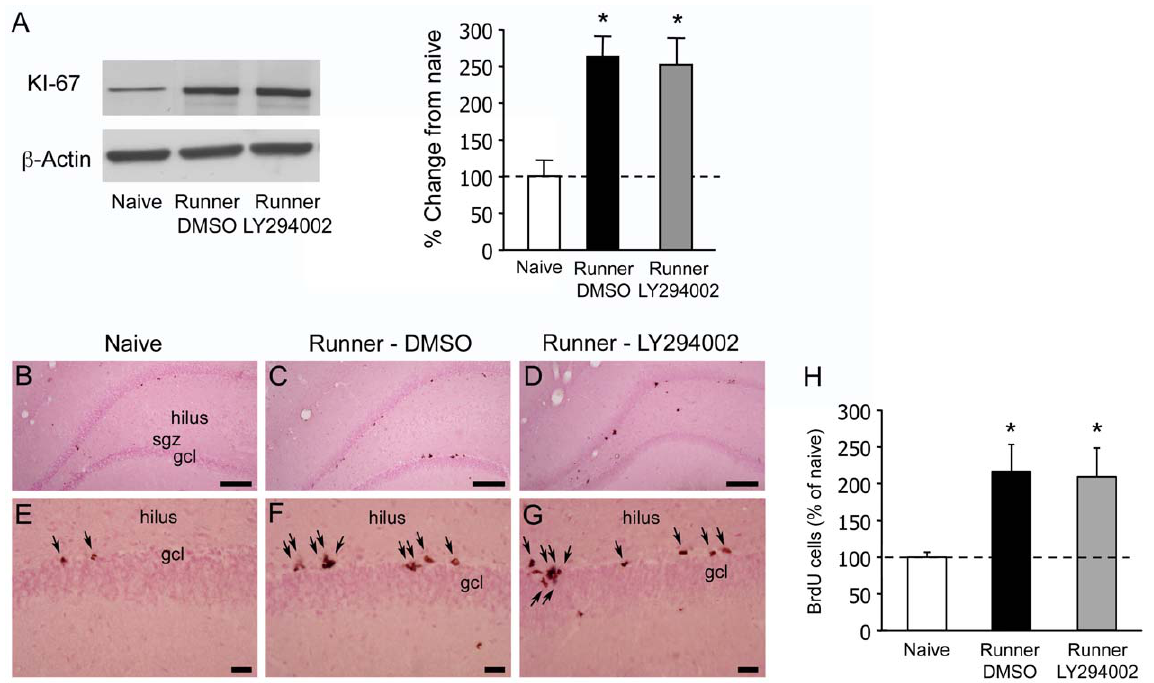
Figure 4. Effect of running and inhibition of the PI3K-Akt signaling pathway on dentate gryus cell proliferation. A. Expression of KI-67 in the dentate gyrus following exercise. KI-67 protein levels are increased in both DMSO-treated runner (Black bars, n=4) and LY294002-treated runners (Grey bars, n=4) compared with naı¨ve rats (White bars, n=4). Sample blots for each group are represented on the left panel. 4B–D, Representative light photomicrographs of Nuclear fast Red-stained sections shows distribution of BrdU immunoreactive nuclei in the dentate gyrus of (B) naı¨ve, (C) DMSO-treated and (D) LY294002-treated runners; sgz, subgranular zone. E–G, Higher magnification illustrates increased numbers of proliferating cells in the sgz in (E) naı¨ve rats, (F) DMSO-treated runners and (G) LY294002-treated runners. H, Quantitative data 2 hours after the last of three BrdU injections are expressed as the number of BrdU-cells (% of naives) to show comparable results with western blotting analyses of KI-67. Scale bars 200 m m ( B–D ), 100 m m ( E–G ).